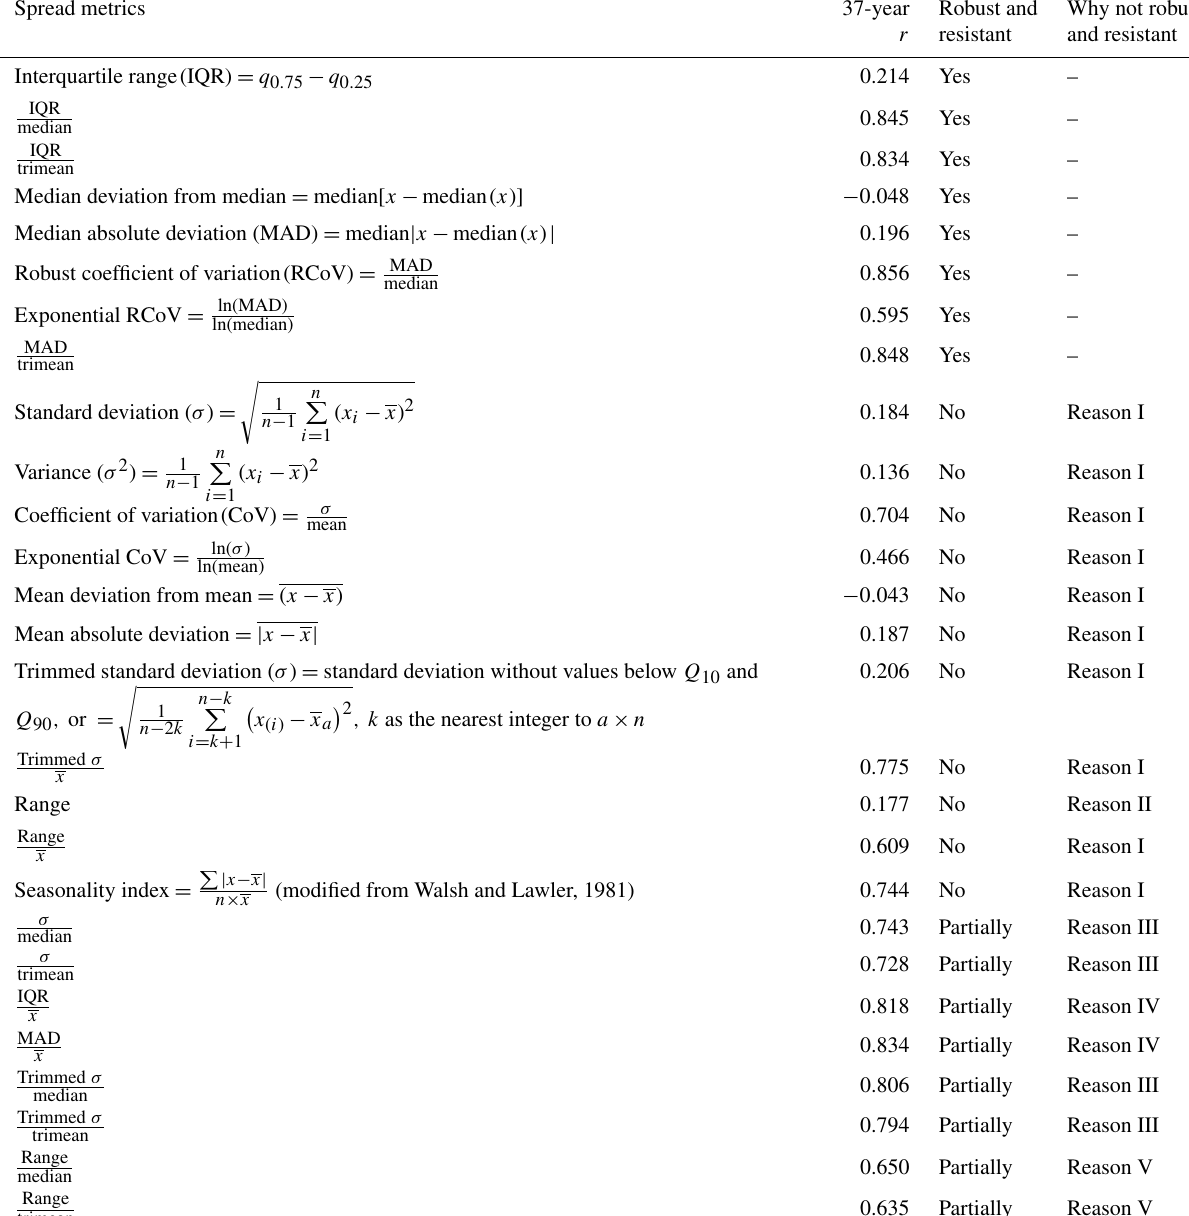
Table B1. Description of the 26 spread metrics tested, adapted from Wilks (2011), and the 37-year r ’s from the r -filtered monthly data. q 0 . 25 is the 25th percentile (first quartile), q 0 . 5 is the 50th percentile (median), and q 0 . 75 is the 75th percentile (third quartile). Trimean =